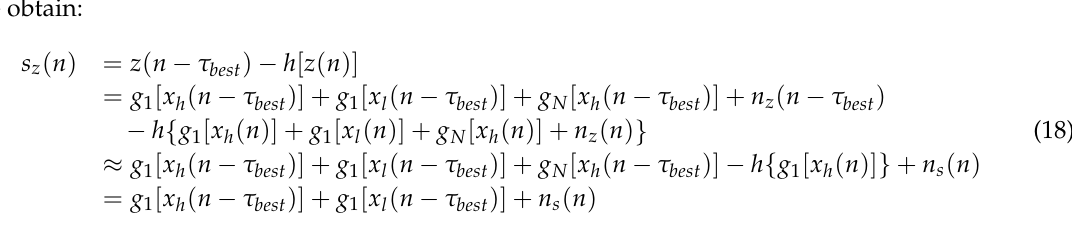
Figure 3. Principle of nonlinearity mitigation.